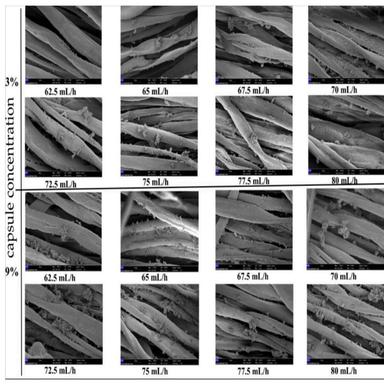
SEM images of PCM-Cott yarns fabricated at various capsule concentrations and dispersion feeding rates (1.00 kx).